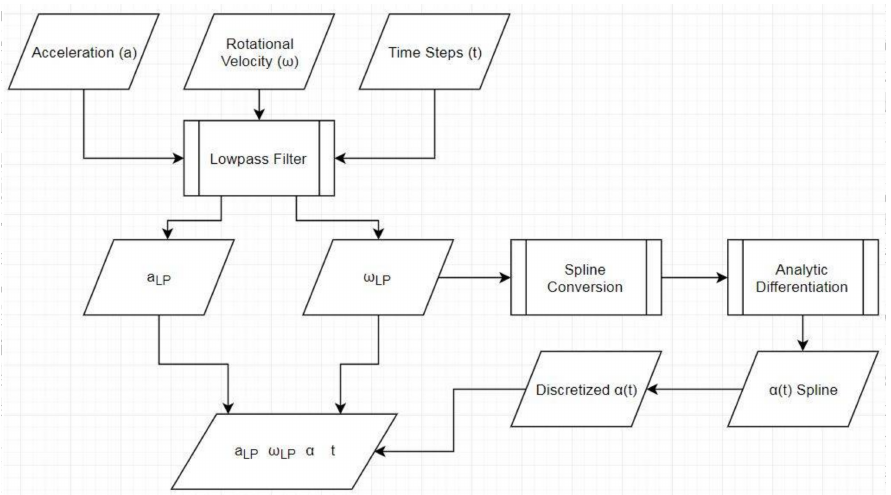
Figure 1. Flowchart detailing how the data is pre-processed before being fed into SFO. The subscript “LP” denotes that the variable has been lowpass